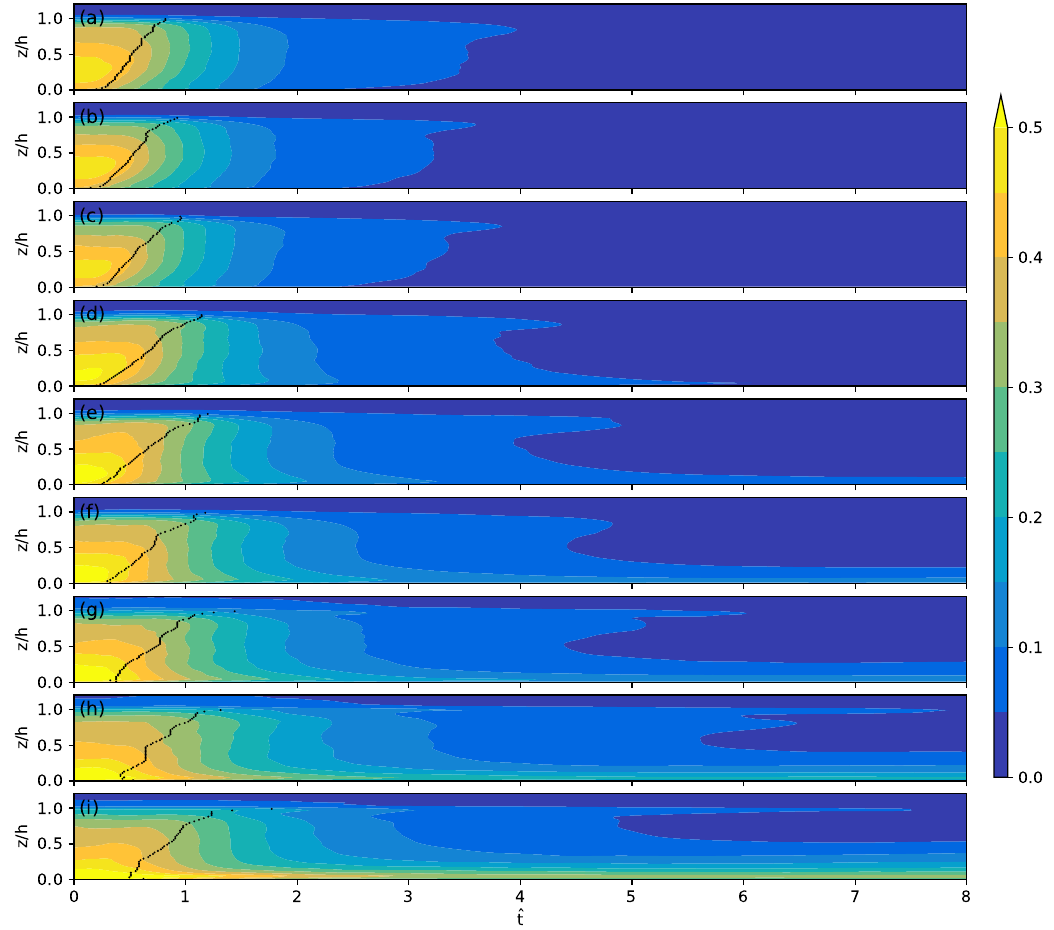
Figure 3. Time series of vertical profiles of normalized TKE in the ( a ) B3, ( b ) B2, ( c ) B1, ( d ) I3, ( e ) I2, ( f ) I1, ( g ) S3, ( h ) S2, and ( i ) S1 cases. The black dots below z = h indicate the times when TKE at ˆ t = 0 decreases by